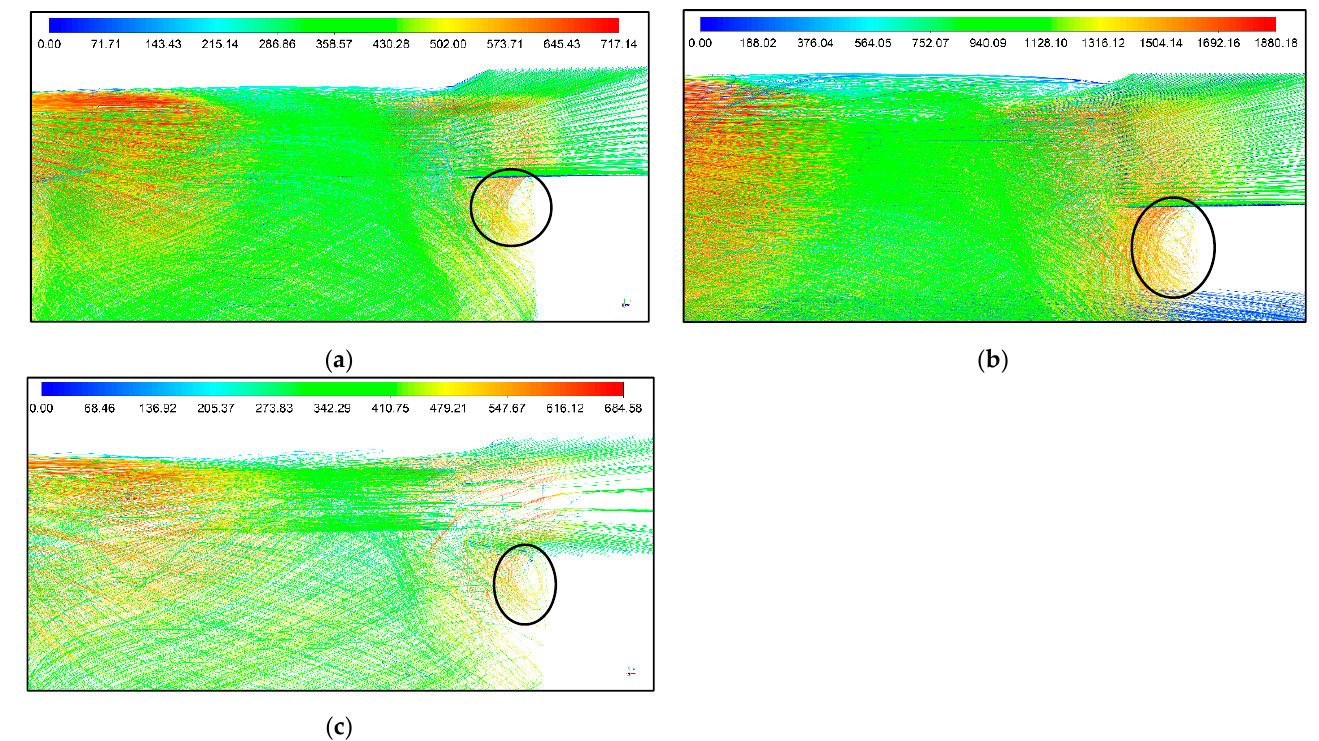
Figure 16. Velocity streamlines obtained for SVT with ( a ) air ; ( b ) He ; and ( c ) CO 2 . The changing of the vortex structure is visible in Figure 17. It has a more elongated shape in comparison to SVT of a smaller diameter. Such changes in the structure can be related to the increase of the velocity magnitude.